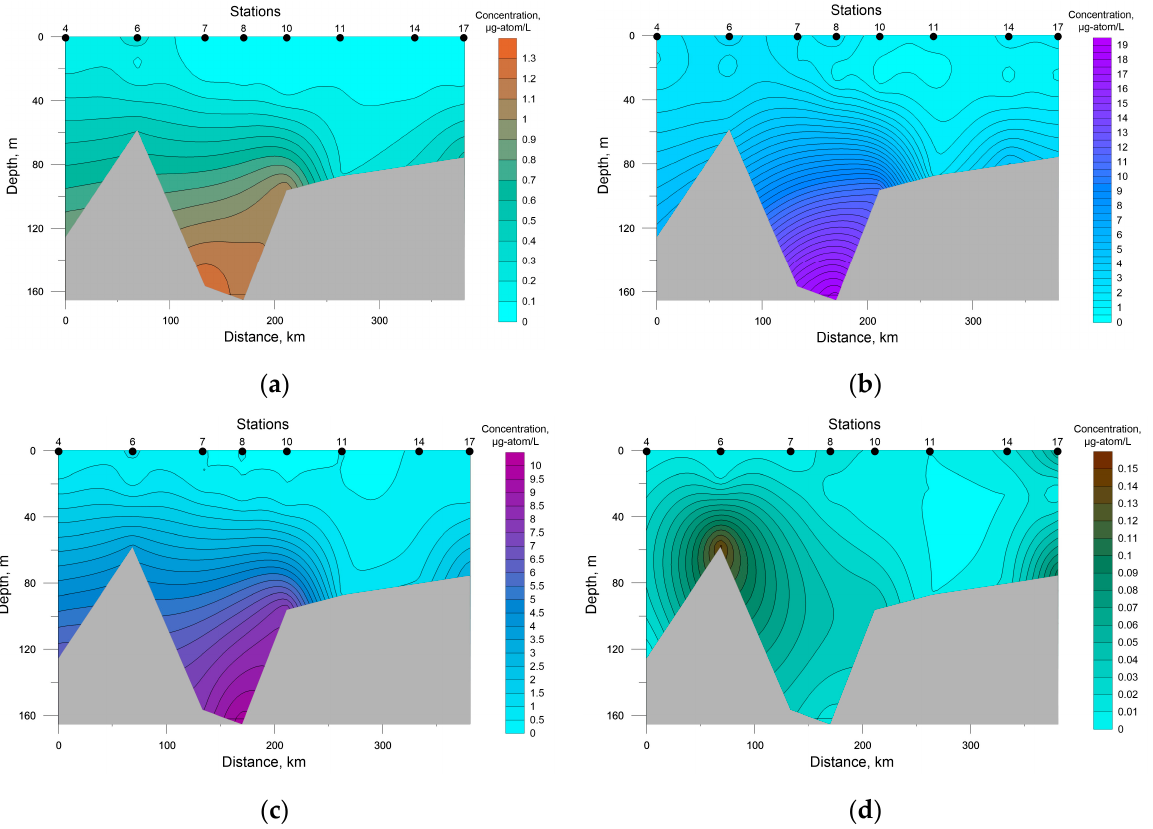
Figure 4. Distribution of nutrients concentration at the investigated transects in the southwestern Kara Sea; ( a ) P-PO 4 , ( b ) Si-SiO 2 , ( c ) N-NO 3 , ( d ) N-NO 2 .